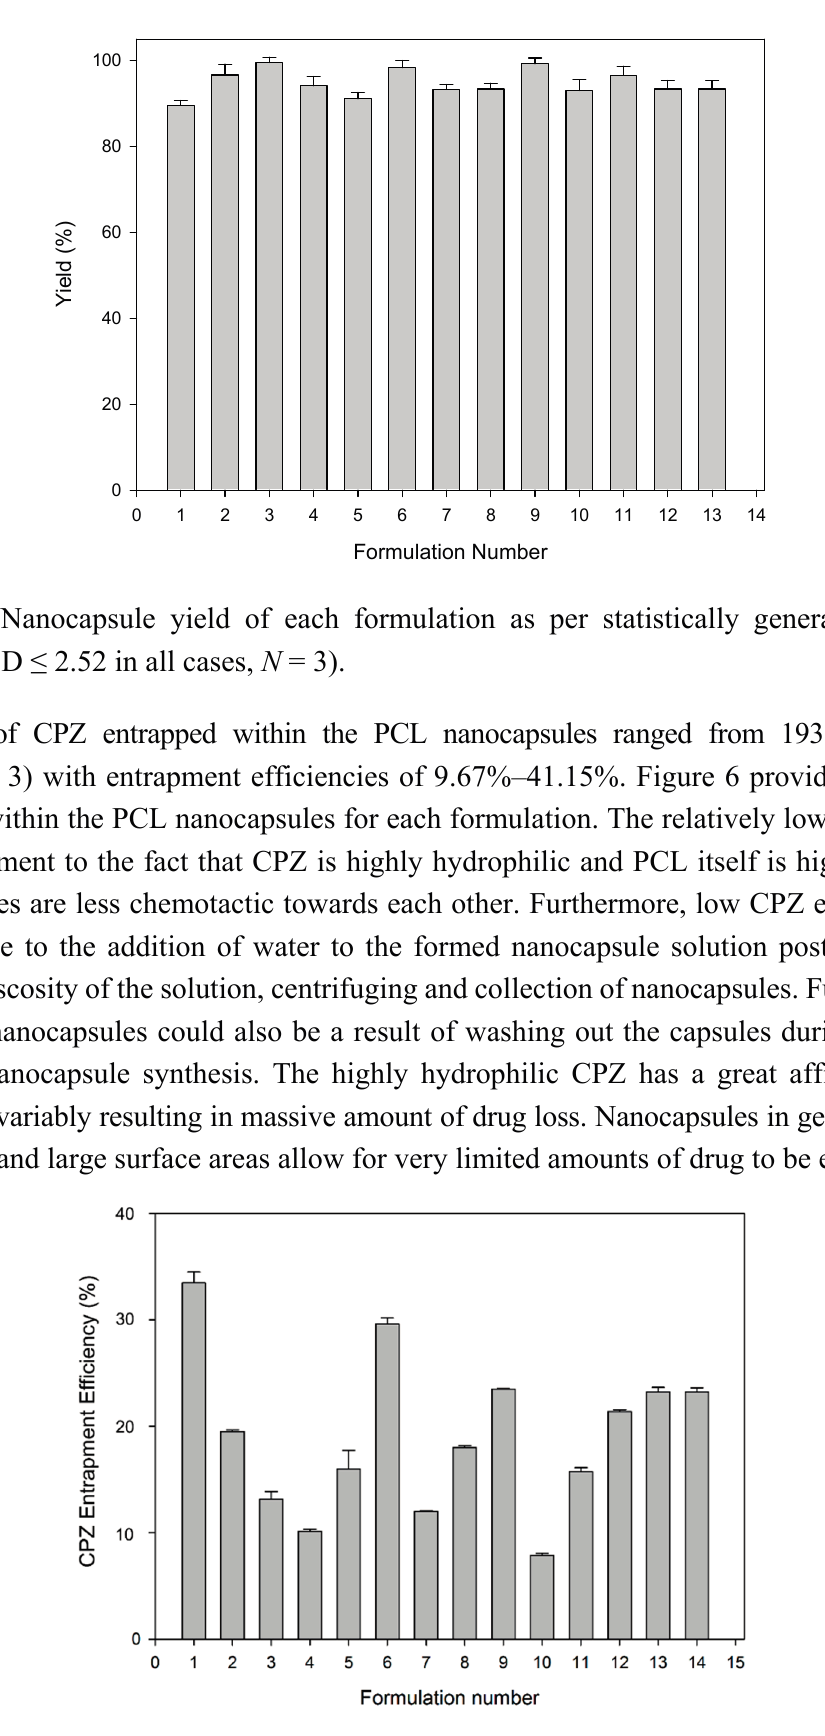
Figure 6. Percentage drug entrapment of CPZ within PCL nanocapsules as per the statistical experimental design template generated ( N =